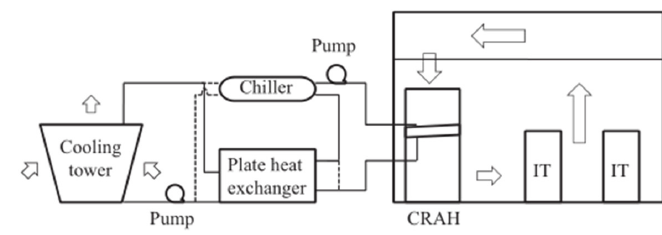
Figure 7. Cooling tower system [32].